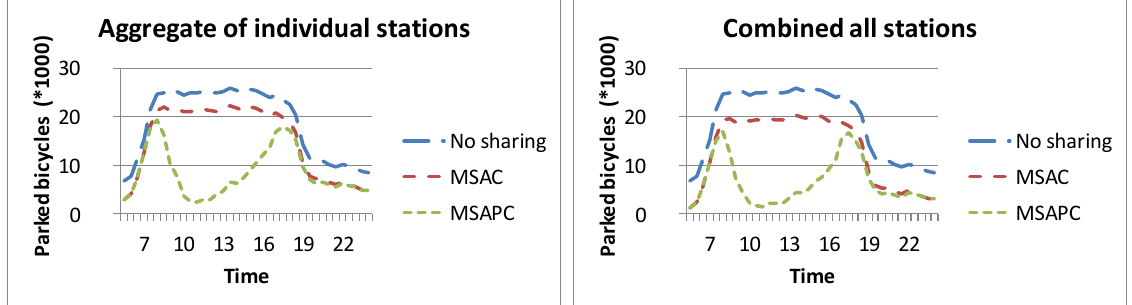
Figure 4. Distribution of parked bicycles over time for different sharing cases, central stations of the four largest cities